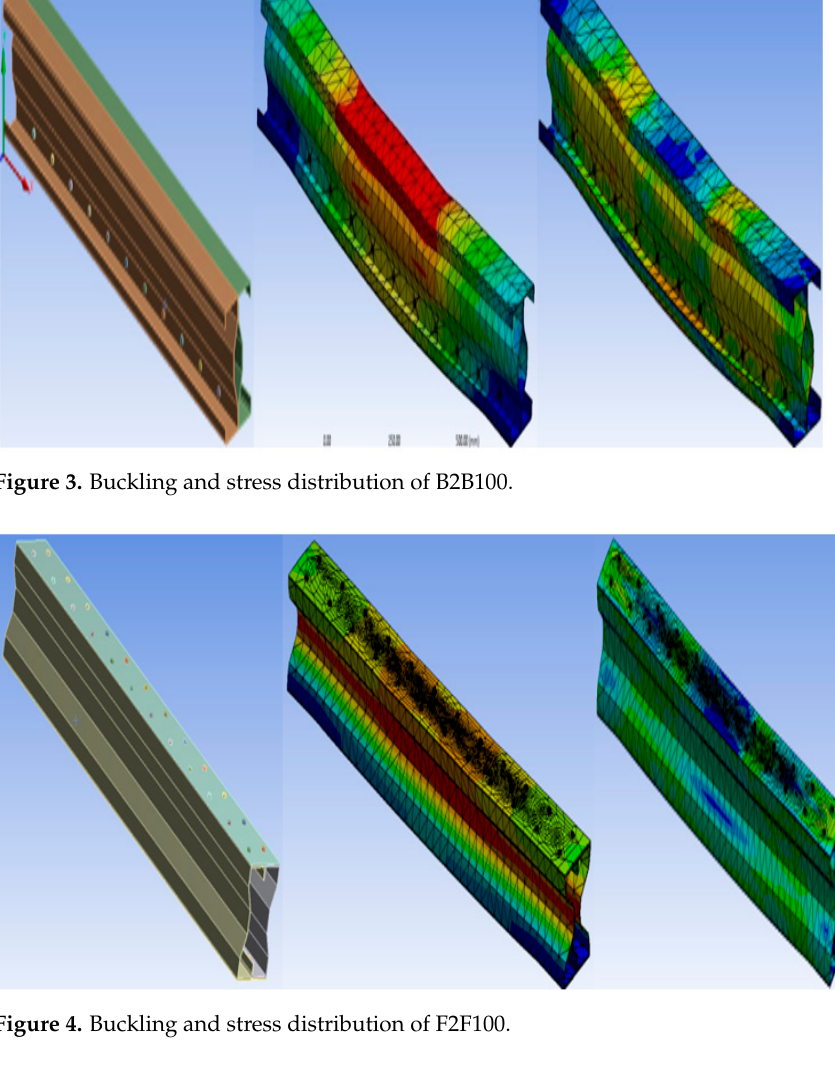
Figure 4. Buckling and stress distribution of F2F100.